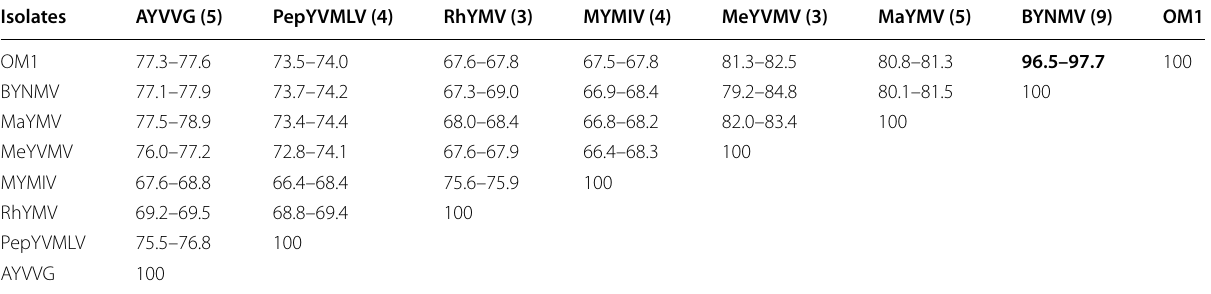
Sequences were selected of the most similar species from the blast comparison